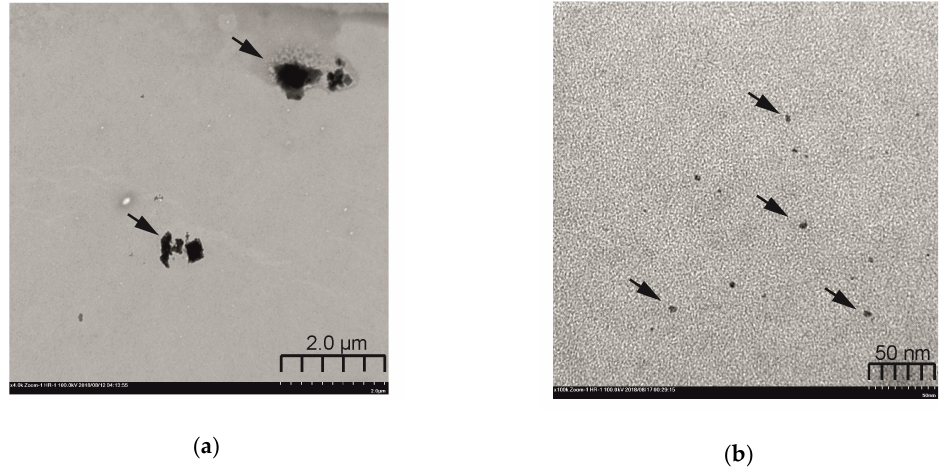
Figure 5. TEM image of aqueous solutions of GCR-1 ( a ), GCR-2 and two-fold excess of MG ( b ).